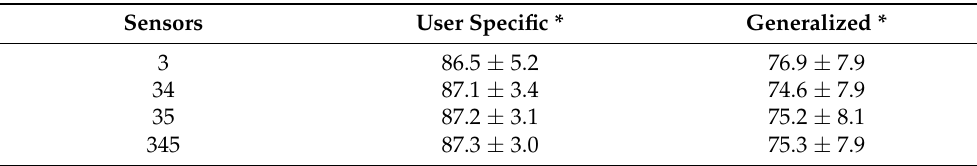
Table 4. Classification results for different sensor combinations when using the AP™ normally. Shown are mean accuracies (%) and the corresponding standard deviation of all seven subjects when developing user-specific or generalized models.